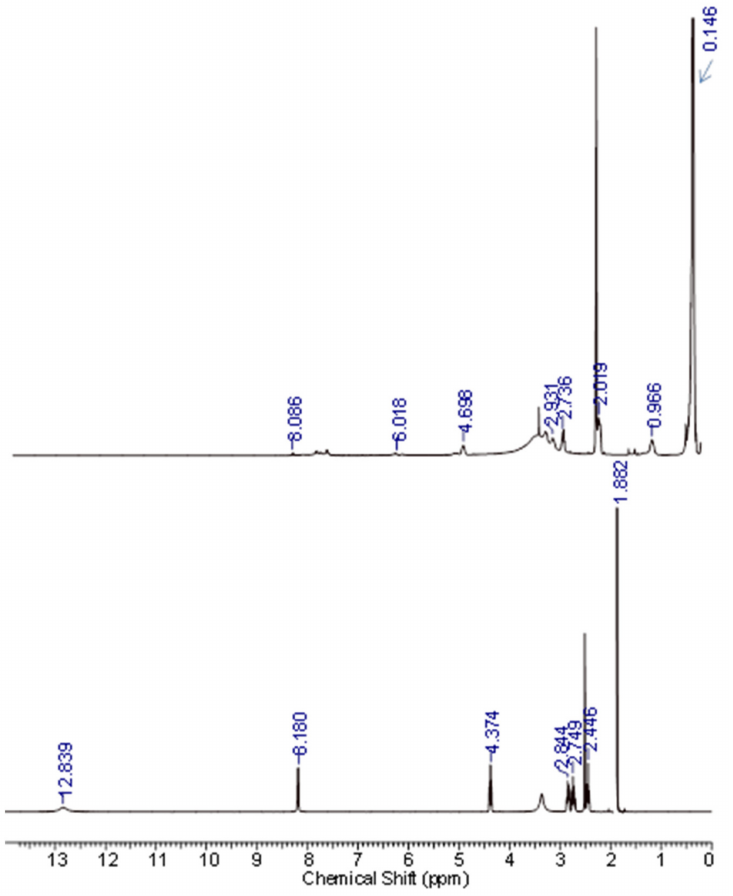
Figure 2. 1 H-NMR spectra of NAC ( bottom ) and PNAC-10-100 modified polysiloxane copoly- mer ( top ).